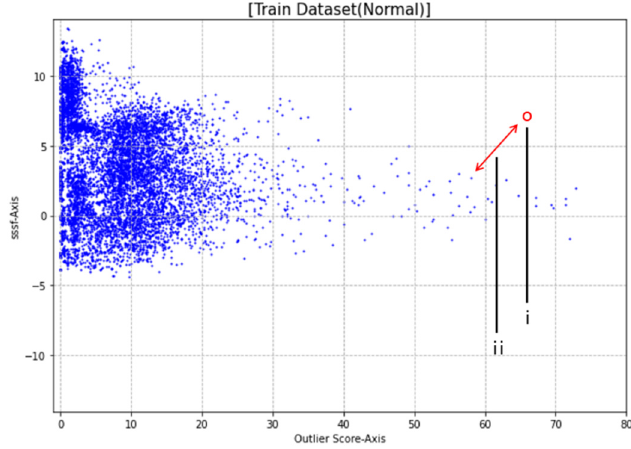
Figure 4. Reliability score calculation method. (i) Test data calculated with SSSF and outlier score. (ii) Reliability score calculated based on two-dimensional data, SSSF, and outlier score.